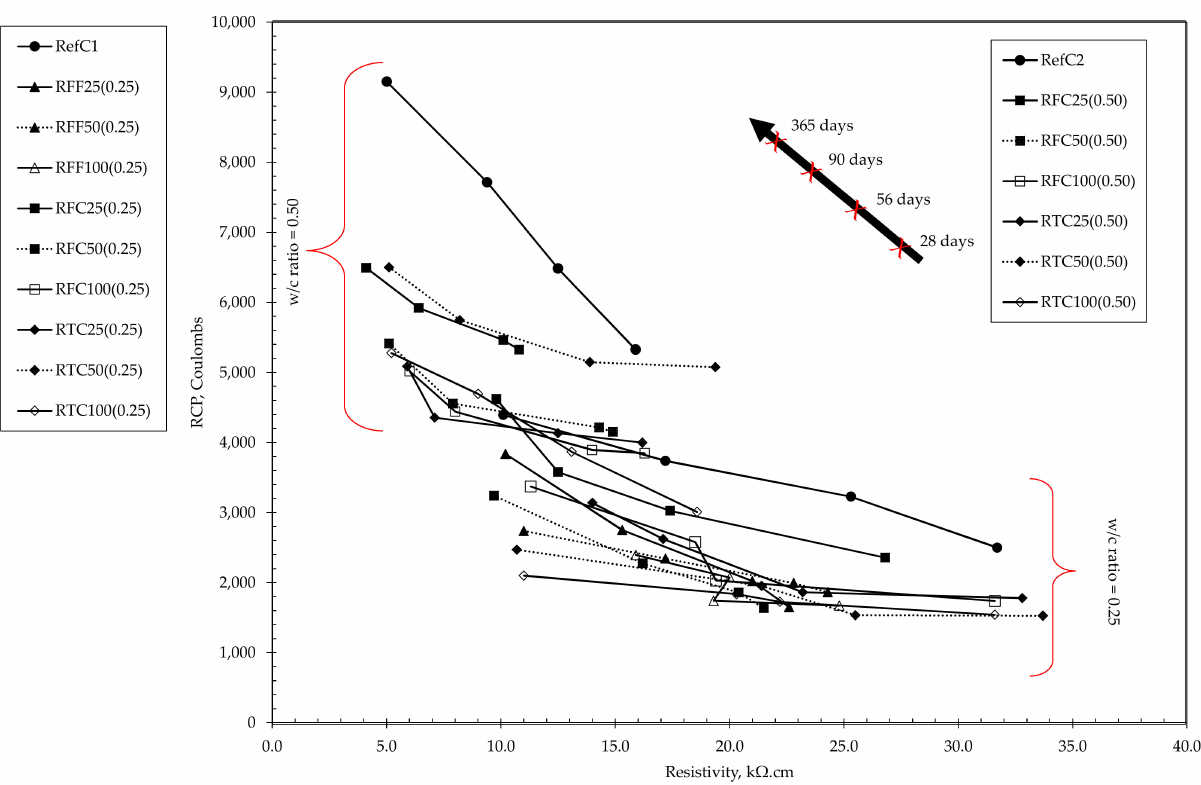
Figure 3. Relationship between chloride resistance and resistivity of concrete mixtures at 28, 56, 90 and 365